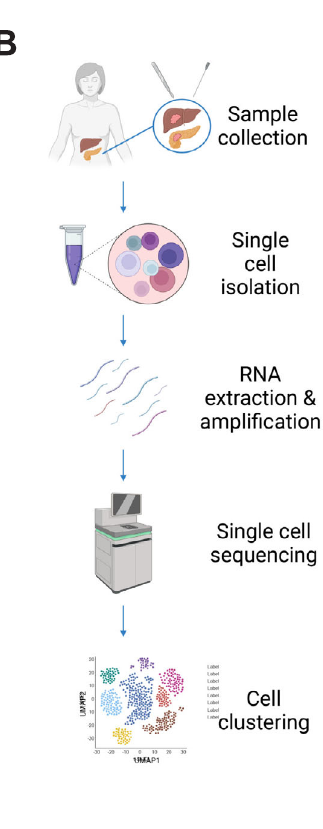
and color-coded. CAF cancer-associated fi broblast, NK natural killer, UMAP uniform manifold approximation and projection. D Heatmap of the fi ve most differentiallyexpressedgeneswithineachcluster.Colorscorrespondtothecluster colors in Fig. 1 C . E Proportional distribution of each cell cluster by individual